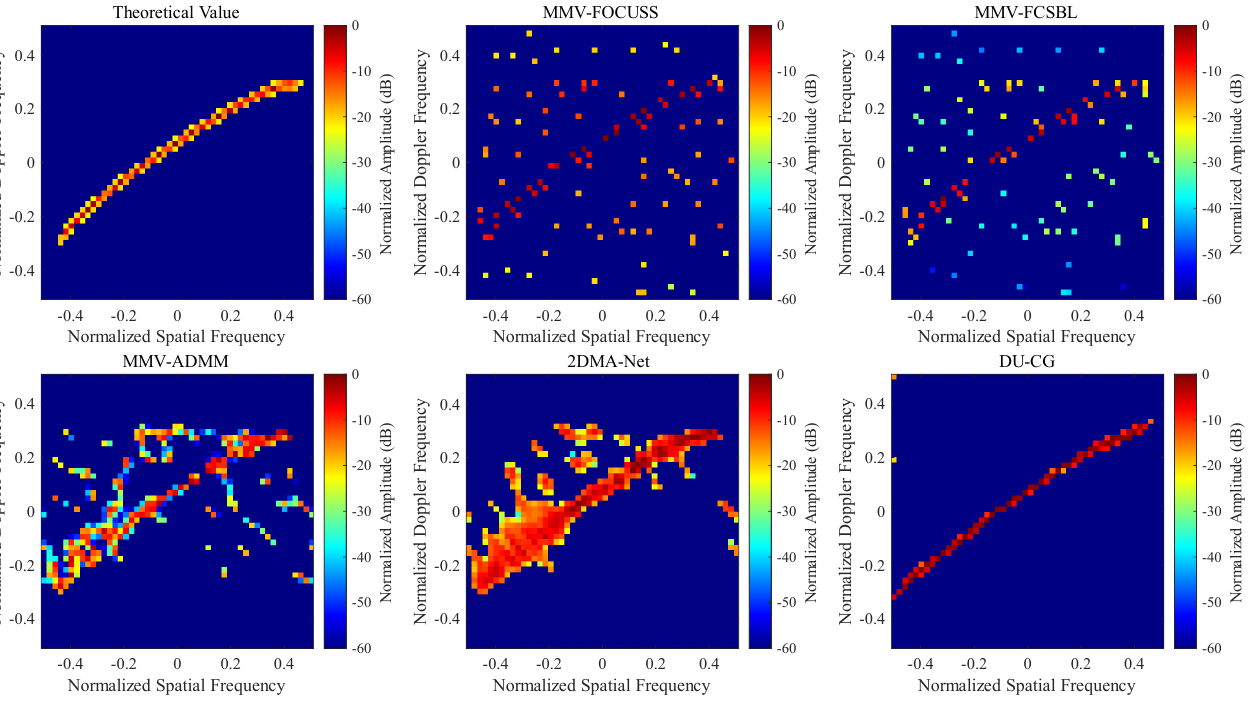
Figure 13. Clutter spectrum estimation results obtained using different methods in the non-ideal case with the clutter ridge slope as 0.67, the non-side-looking angle as 15.50°, the ICM as 0.24 m/s, and the array element amplitude/phase error as 0.10/4°.